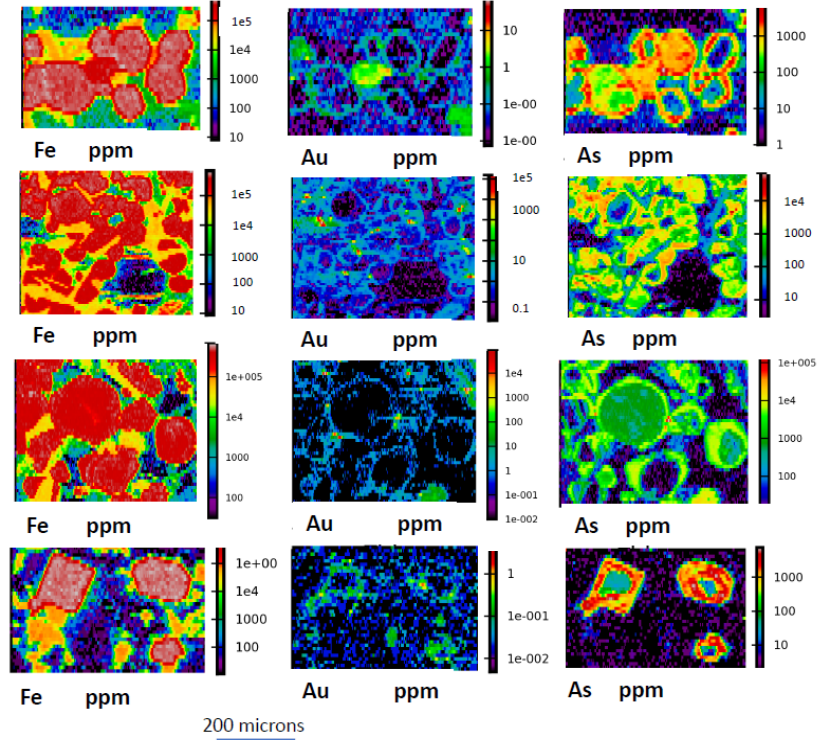
Figure 6. Four examples of pyrite rims on pyrite in the Carbon Leader Reef (CLR) distinctly outlined by elevated As and Au. All maps in ppm. High Fe ppm (red-white) show the pyrite. The red-orange-yellow spots on the gold images indicate micro-particles of free gold on the invisible gold bearing arsenian pyrite rims.